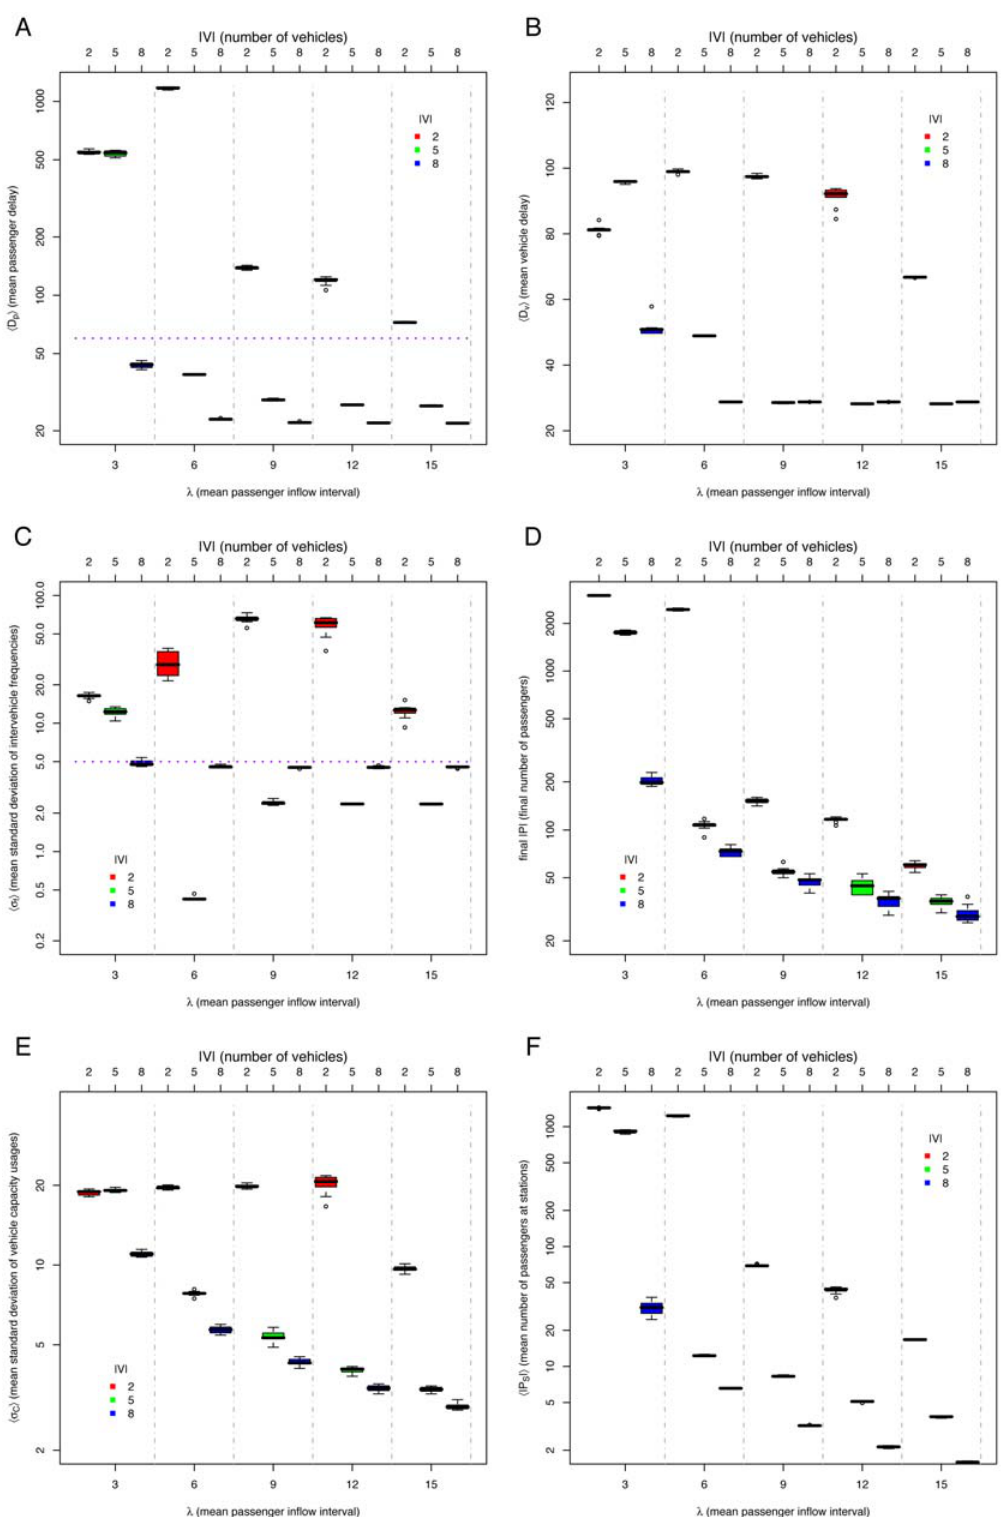
Figure 11. Simulation results for adaptivemaximum method , varying mean passenger inflow intervals l (lower x axis, separated by vertical dashed lines) and number of vehicles V j j (upper x axis, also indicated by color of boxes): (A) mean passenger delay S D p T (data above horizontal dotted line indicates poor system performance), (B) mean vehicle delay S D v T , (C) mean standard deviation of intervehicle frequencies S s f T (data above horizontal dotted line implies unstable headways), (D) final number of passengers P j j , (E) mean standard deviation of vehicle capacity usage S s C T , and (F) mean number of passengers at stations S P s j j T .